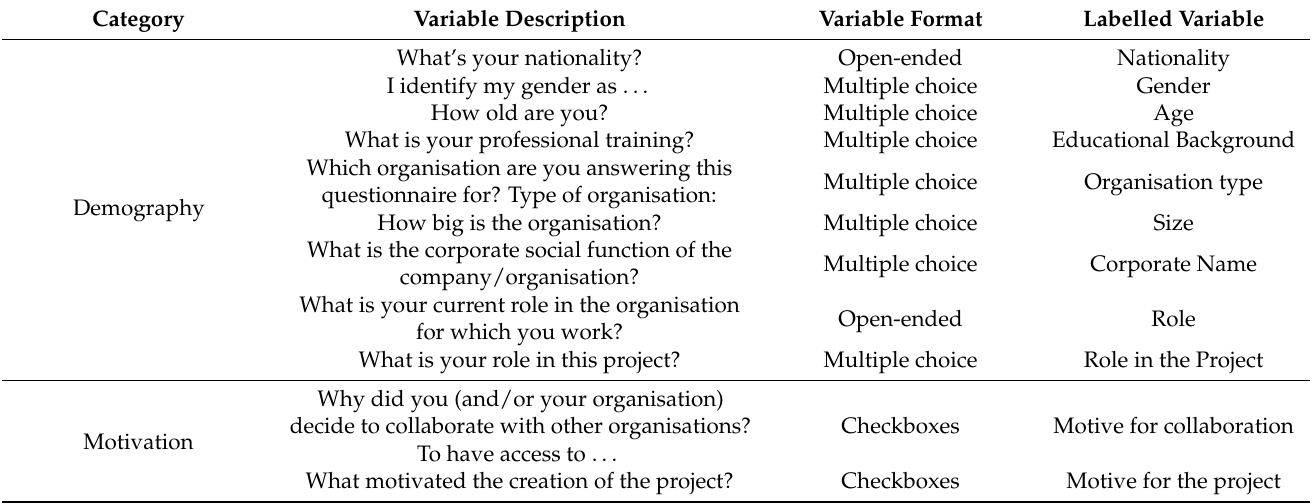
Table 4. Categories, Variables, Format and Labelled